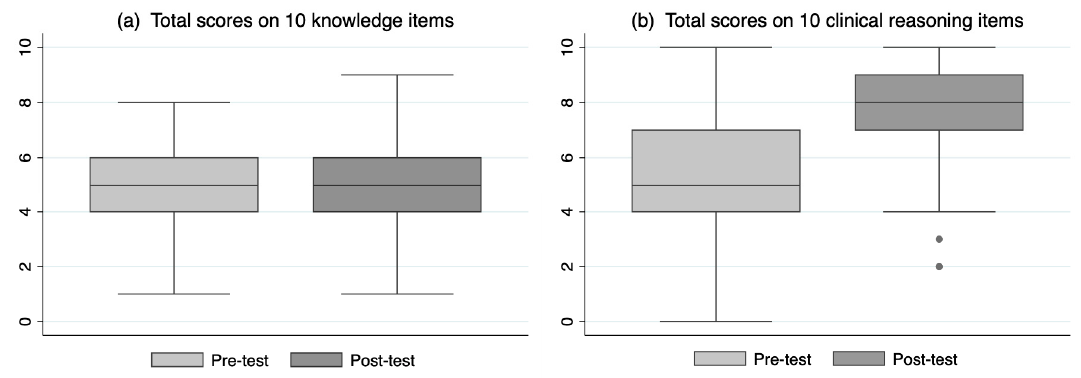
Figure 4. Total scores on knowledge ( a ) and clinical reasoning ( b ) items.